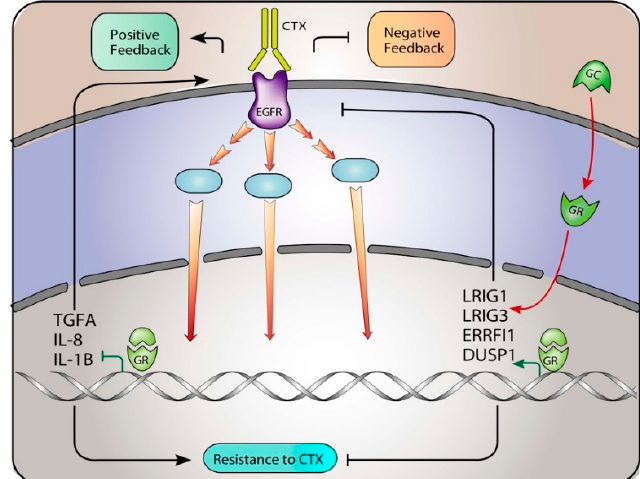
Figure 7. A model depicting the rewiring of resistance to cetuximab in colorectal cancer xenopatients. EGFR positive feedback loops are increased in cetuximab resistant cells that under cetuximab (CTX) stimulus displayed increased abundance of IL-8, IL-1B, TGFA and HBEGF, along with the dampened production of LRIG1, LRIG3, ERRFI1 and DUSP1. GR modulation re-activates EGFR negative feedback loops in cetuximab-resistant cells.